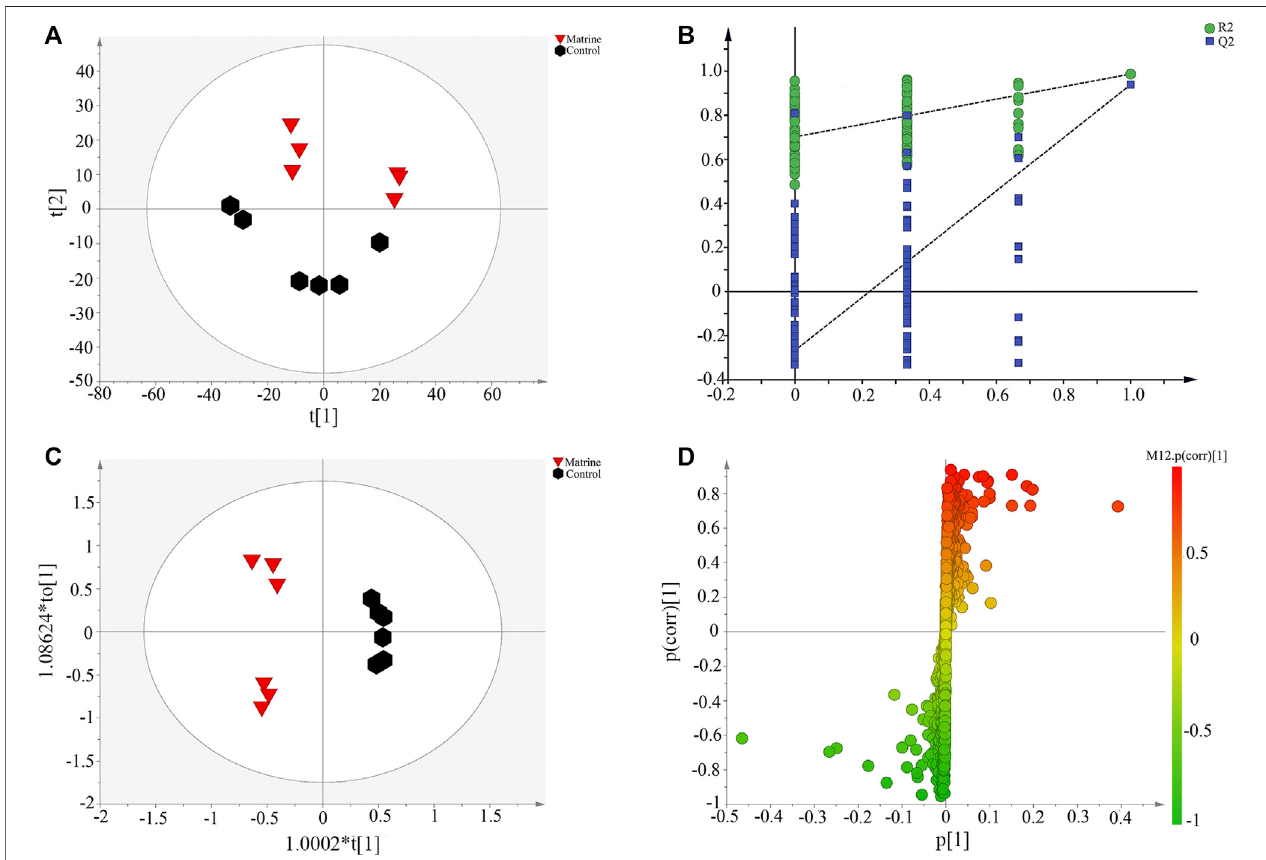
FIGURE 2 | (A )Scatter plot of principal component analysis scores, (B) partial least-squares discriminant analysis model corresponding validation plot, (C) Scatter plot of orthogonal partial least-squares discriminant analysis (OPLS-DA) scores, and (D) S-plot based on OPLS-DA derived from SMMC-7721 cells.